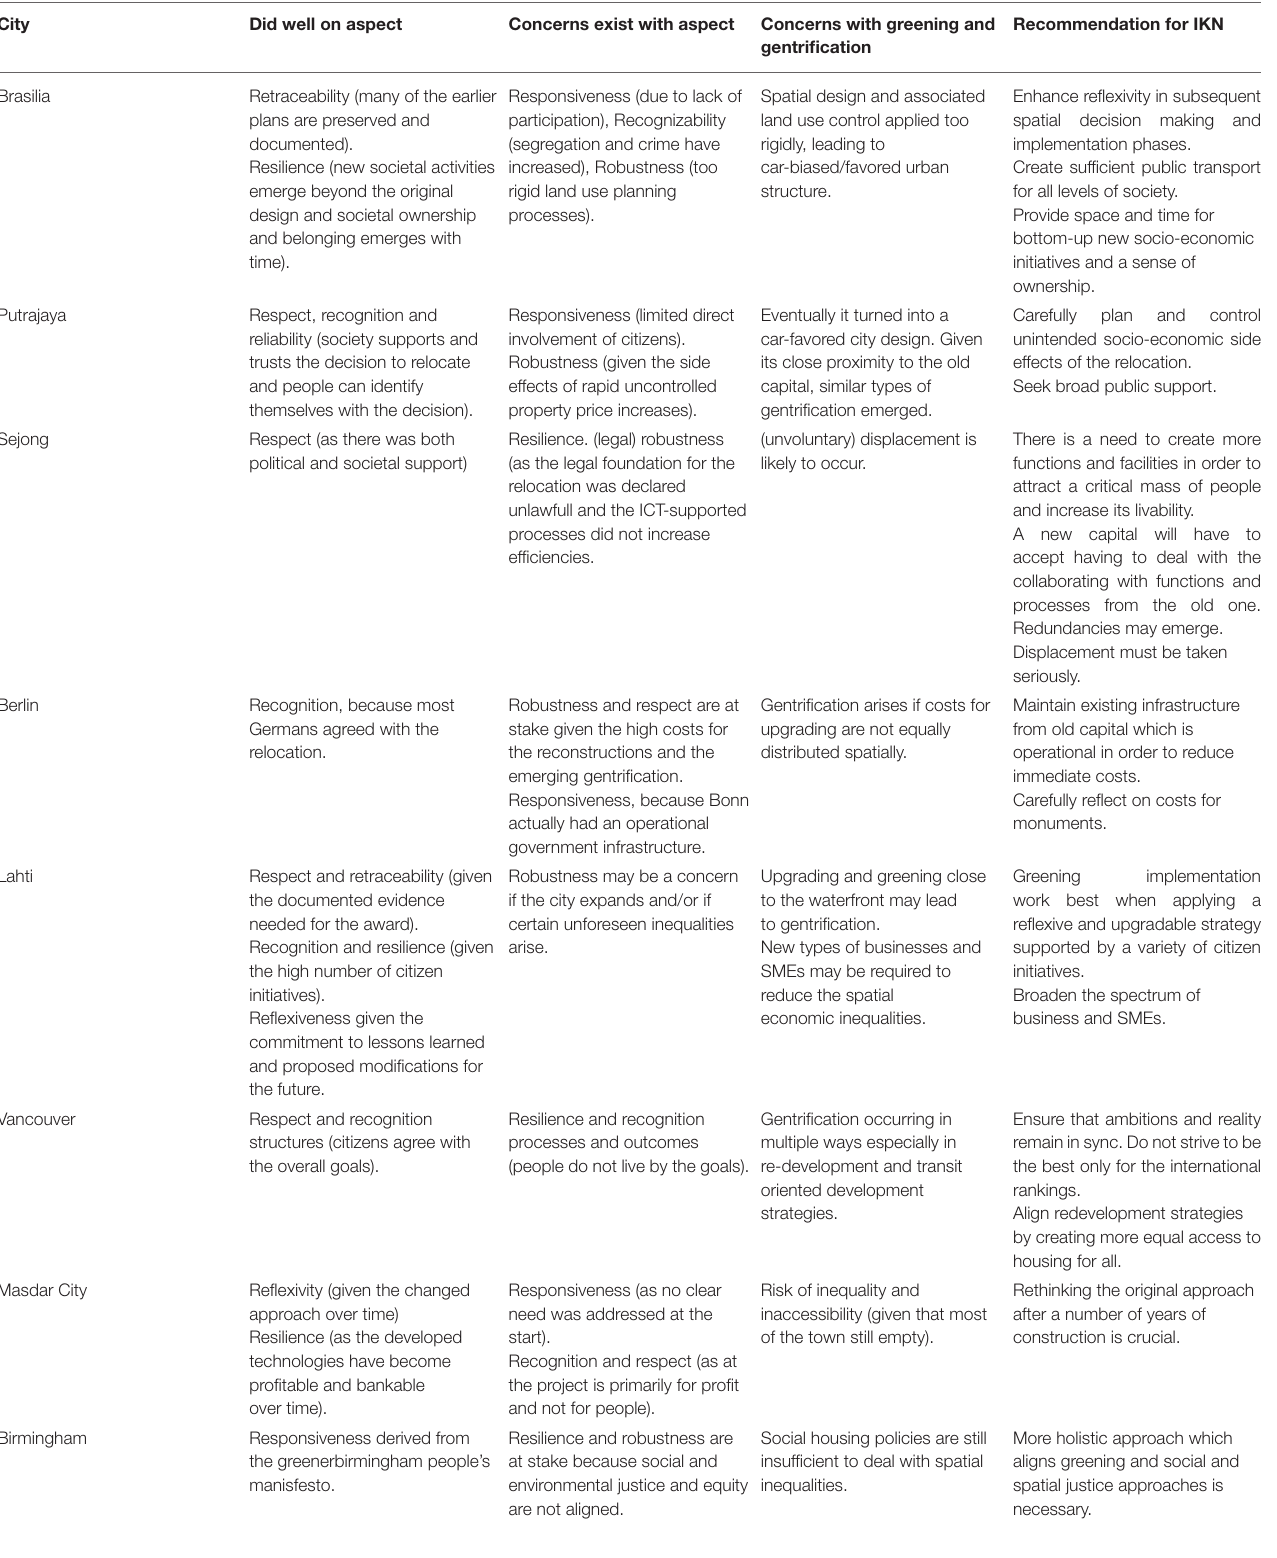
TABLE 4 | Summary of 8R, urban greening and gentrification findings for each selected